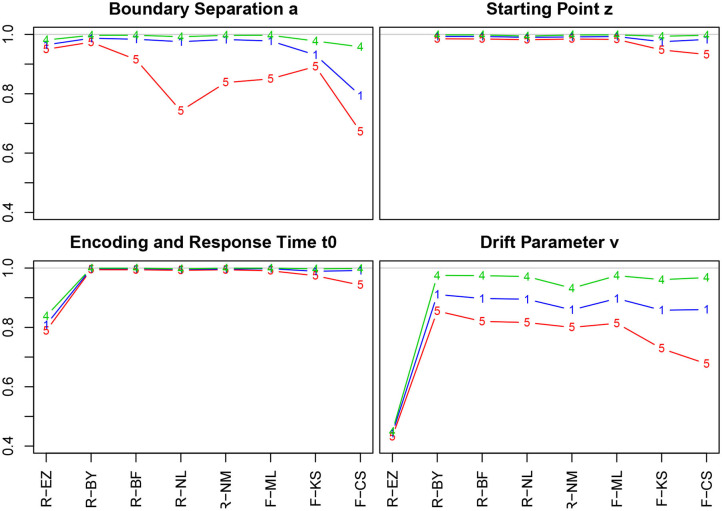
Correlation coefficients of true and estimated parameters by number of trials. red line/symbol “5”: 50 trials; blue line/symbol “1”: 100 trials; green line/symbol “4”: 400 trials; for abbreviations see Figure 3.